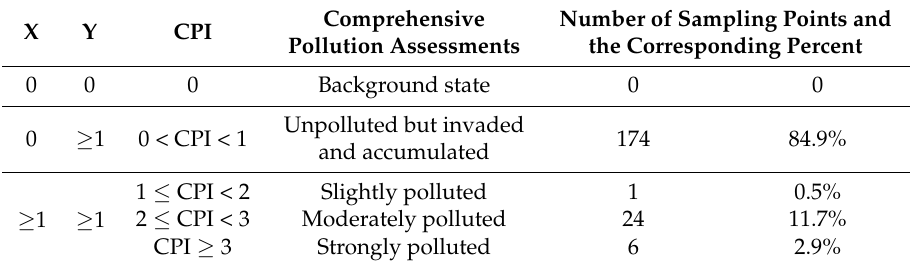
Table 5. Classification standards of the Comprehensive Pollution Index (CPI).